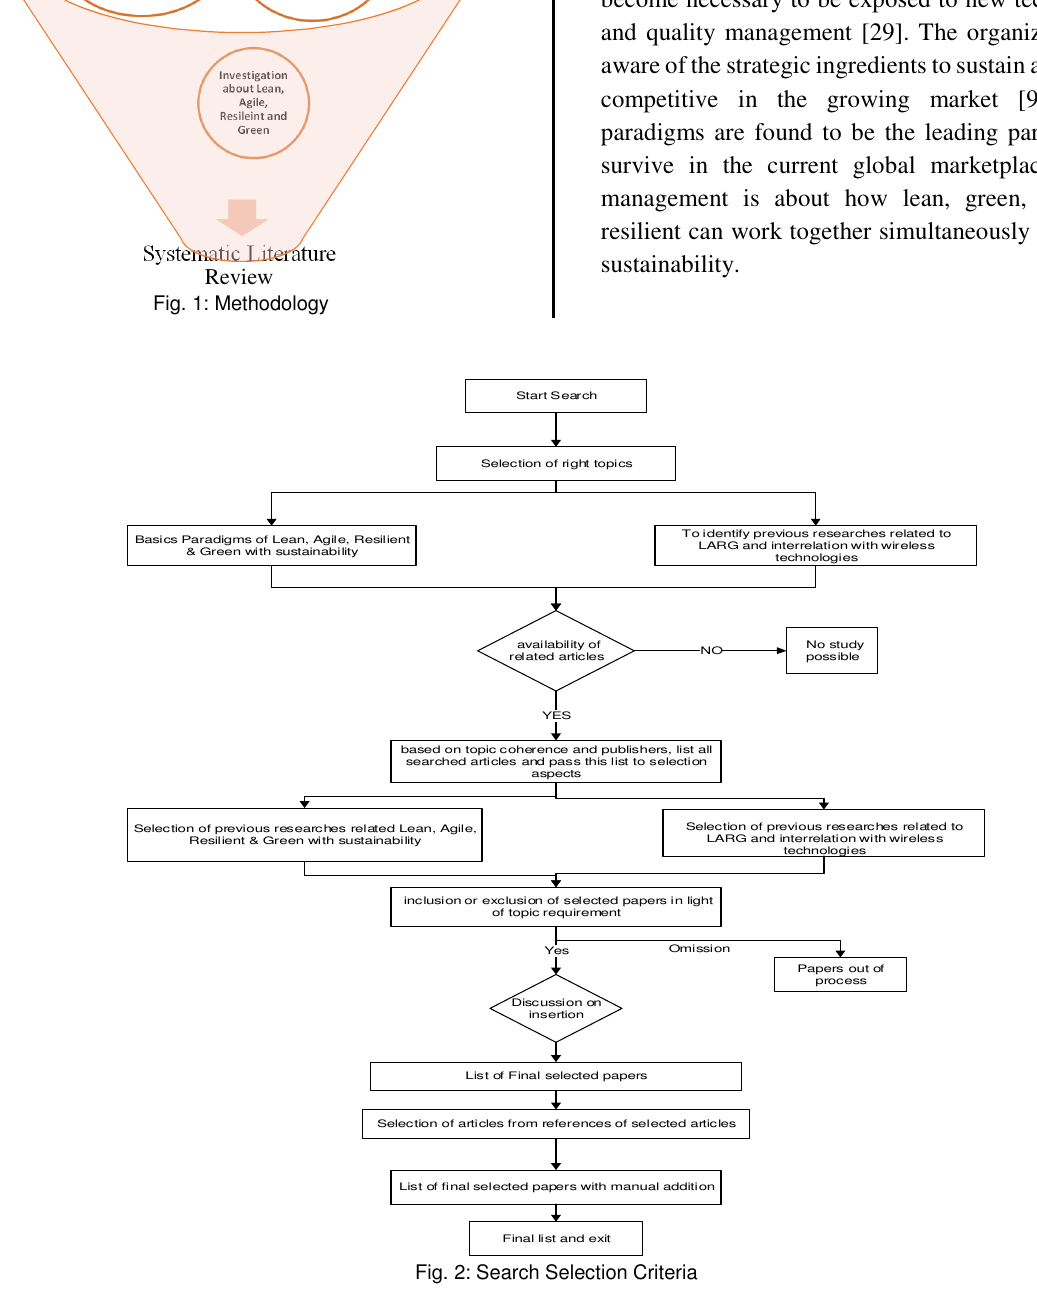
Fig. 2: Search Selection